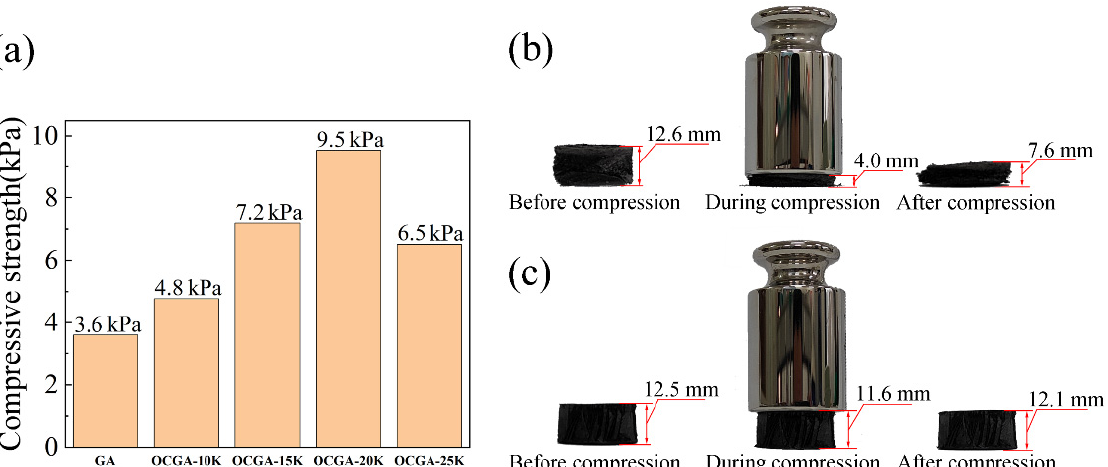
Figure 7. Effect of cell structure on the compression performance. ( a ) Compressive strength of graphene aerogels. ( b ) Shapes of GA before, during compression and after compression. ( c ) Shapes of OCGA-20K before, during and after compression.